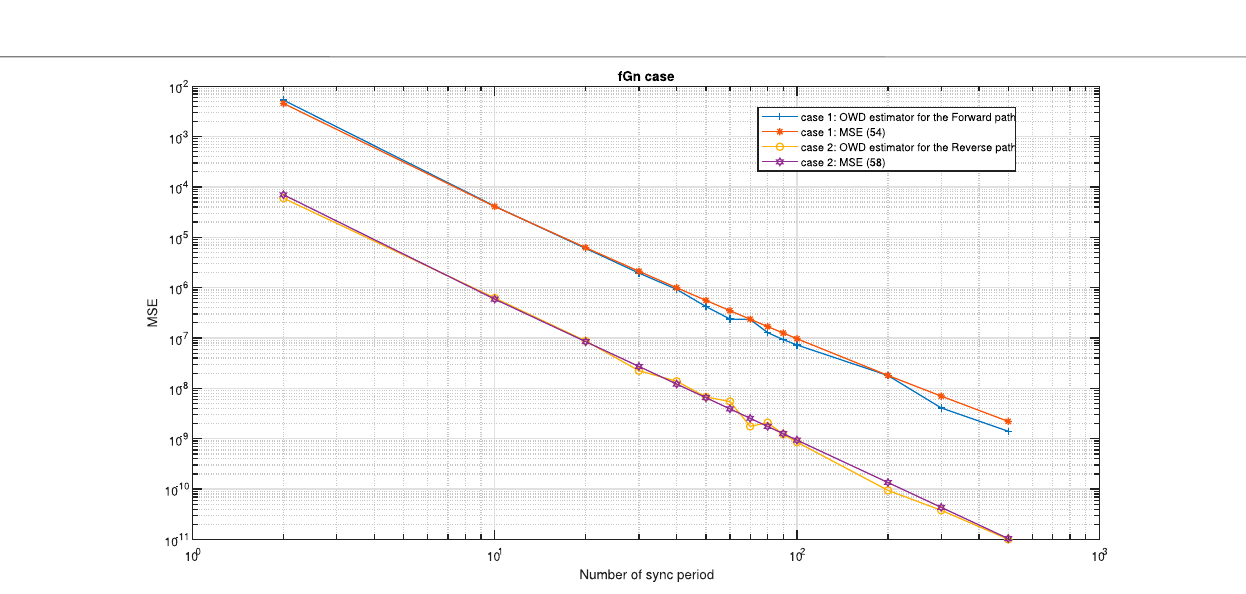
Frontiers in Physics |